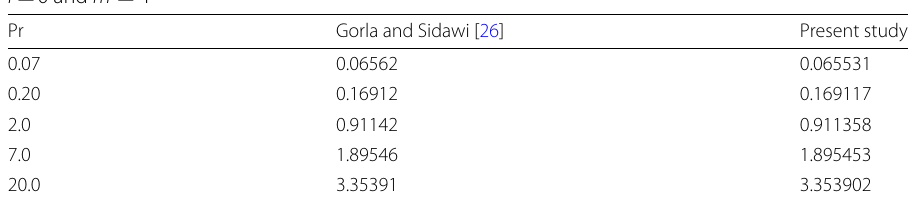
Table 1 Comparison of Nusselt number